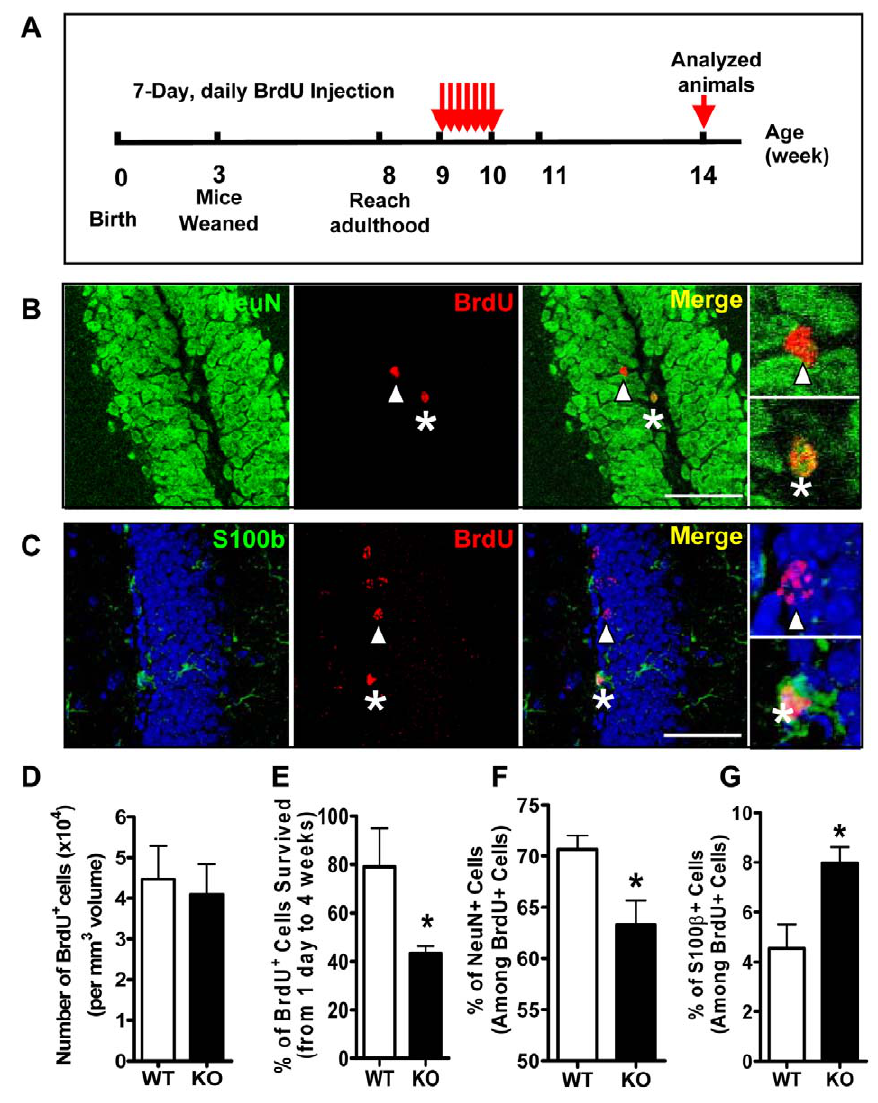
Figure 4. Loss of Fmrp alters the differentiation of neural stem and progenitor cells invivo . (A) Experimental scheme for assessing new cell survival and differentiation in the adult hippocampus. (B,C) Sample confocal images showing newborn cells that had differentiated into NeuN + neurons (B, asterisk) or S100 b + astrocytes (C, asterisk). Asterisks, but not arrowheads, indicate BrdU + cells that have differentiated into either a neuron (H) or an astrocyte (E). (D) At 4 weeks post-labeling, BrdU + cells in the Fmr1 KO DG were no different from WT mice (n=7 WT; n=9 KO). (E) At 4 weeks post-BrdU injection, brains were analyzed for survival of newborn cells in the DG. The ratio of BrdU + cells at 4 weeks post-injection (numbers used for D) over 1 day post-injection (average of BrdU + cells shown in Figure 3D) indicated that Fmr1 KO mice had fewer surviving newborn cells in the DG. (F,G) Quantitative analysis indicated that newborn cells in Fmr1 KO mice differentiated into a lower percentage of neurons (F) but a higher percentage of astrocytes (G) compared with WT mice (n=9 WT; n=9 KO). All data are shown as mean 6 SEM, and Student’s t-test was used for all the analyses. *, p , 0.05, **, p , 0.01 ***, p , 0.001.